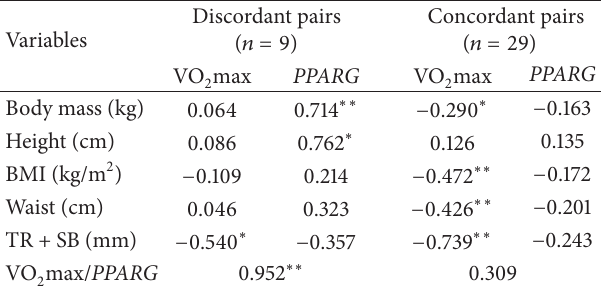
Table 3: Correlation of VO max and PPARG mRNA expression 2 with anthropometric characteristics in MZ twins pairs.